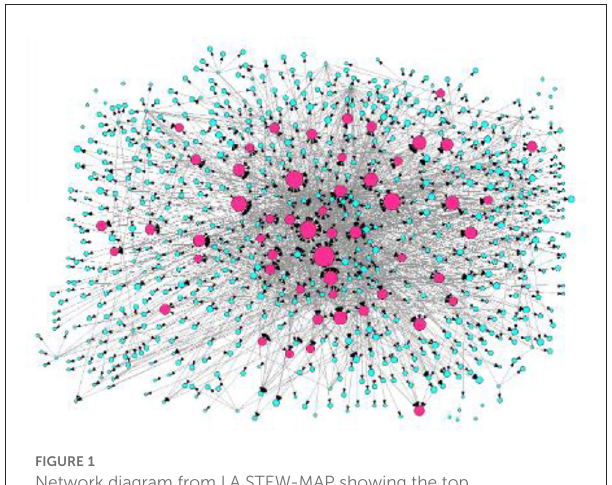
FIGURE1 Network diagram from LA STEW-MAP showing the top